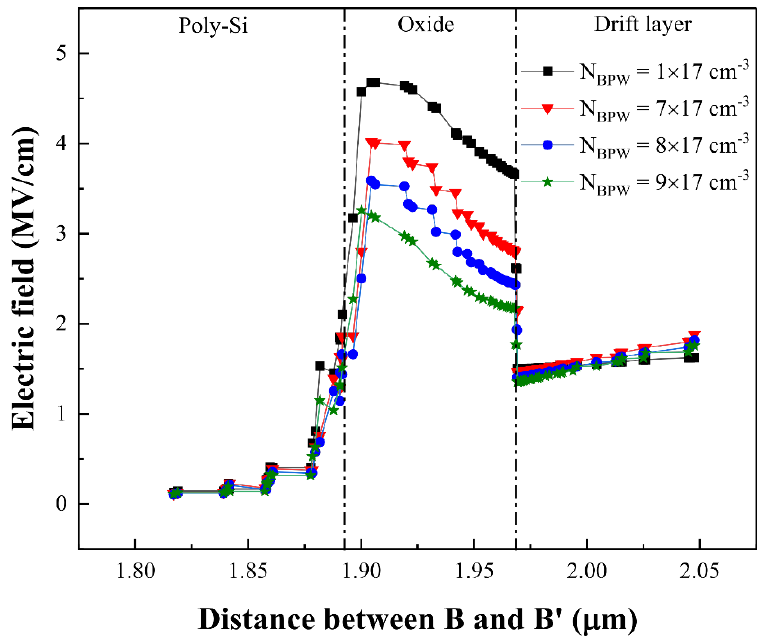
Figure 4. Electric field distribution across the B-B’ section lines of the TMOSFET with N BPW of 1 × 10 17 cm − 3 , 7 × 10 17 cm − 3 , 8 × 10 17 cm − 3 , and 9 × 10 17 cm − 3